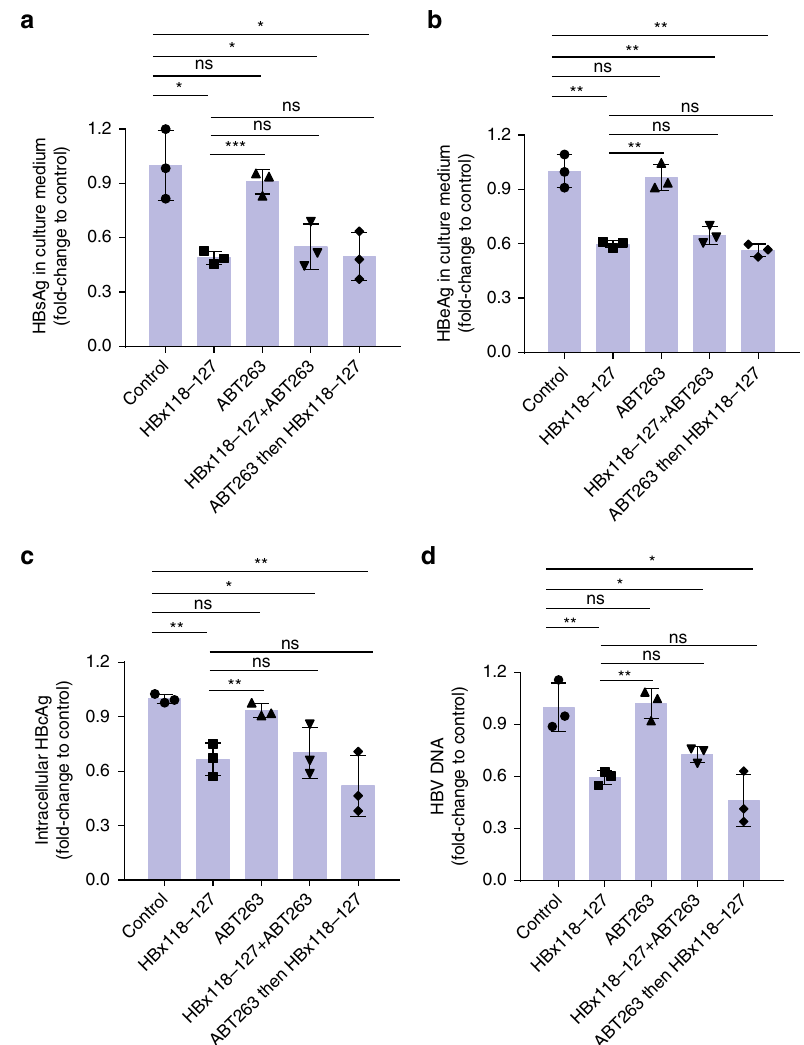
Fig. 7 ABT-263 does not affect the inhibitory effect of HBx118 – 127 on HBV replication in HepG2.2.15 cells. a – d HepG2.2.15 cells were pre-seeded 12 h before peptide treatment. In all panels, from left to right (bars 1 – 5), cells were treated with placebo buffer, HBx118 – 127 only, ABT-263 only, HBx118 – 127 and ABT-263 together, and ABT-263, followed by HBx118 – 127, respectively. The cells in bars 1 – 4 were treated for 48 h, whereas the cells in bar 5 were fi rst treated by ABT-263 for 12 h, followed by treatment with HBx118 – 127 for another 36 h. The fi nal concentration of ABT-263 was 1 μ M in the culture medium, while HBx-aa118 – 127 was delivered by PEP-1 nanoparticles. After 48-h treatment, the protein expression levels of HBV S-antigen (HBsAg) ( a ) and HBV e- antigen (HBeAg) ( b ) in the culture medium, the intracellular protein expression level of HBV core antigen (HBcAg) ( c ), and the HBV viral DNA tilter ( d ) in the culture medium of HepG2.2.15 cells were measured (Methods). The results are shown as fold changes compared to the values obtained from the cells treated with the placebo buffer. Data shown represent mean ± SD. Signi fi cance is indicated on the top. Not signi fi cant (ns): * P < 0.05, ** P < 0.01, *** P < 0.001; two-tailed unpaired t tests ( n = 3 biologically independent samples). Source data are provided as a Source Data fi